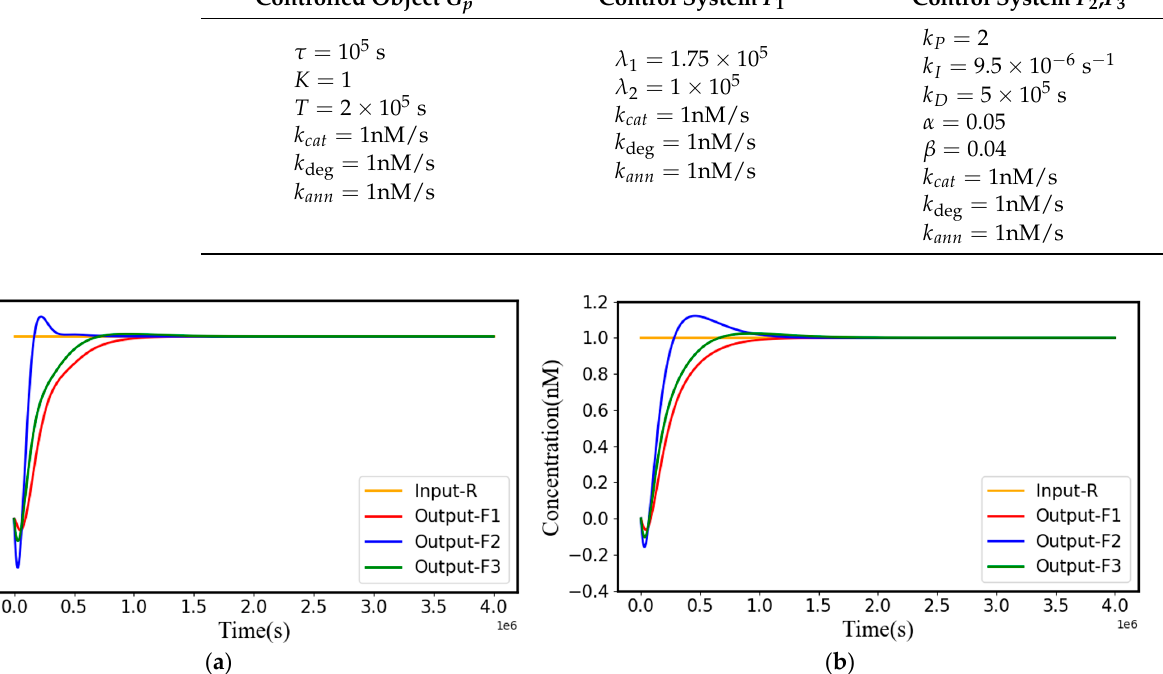
( 1,2,3) F i = i : ( a ) when there is no dis- ( ) 1( ) d t t = .